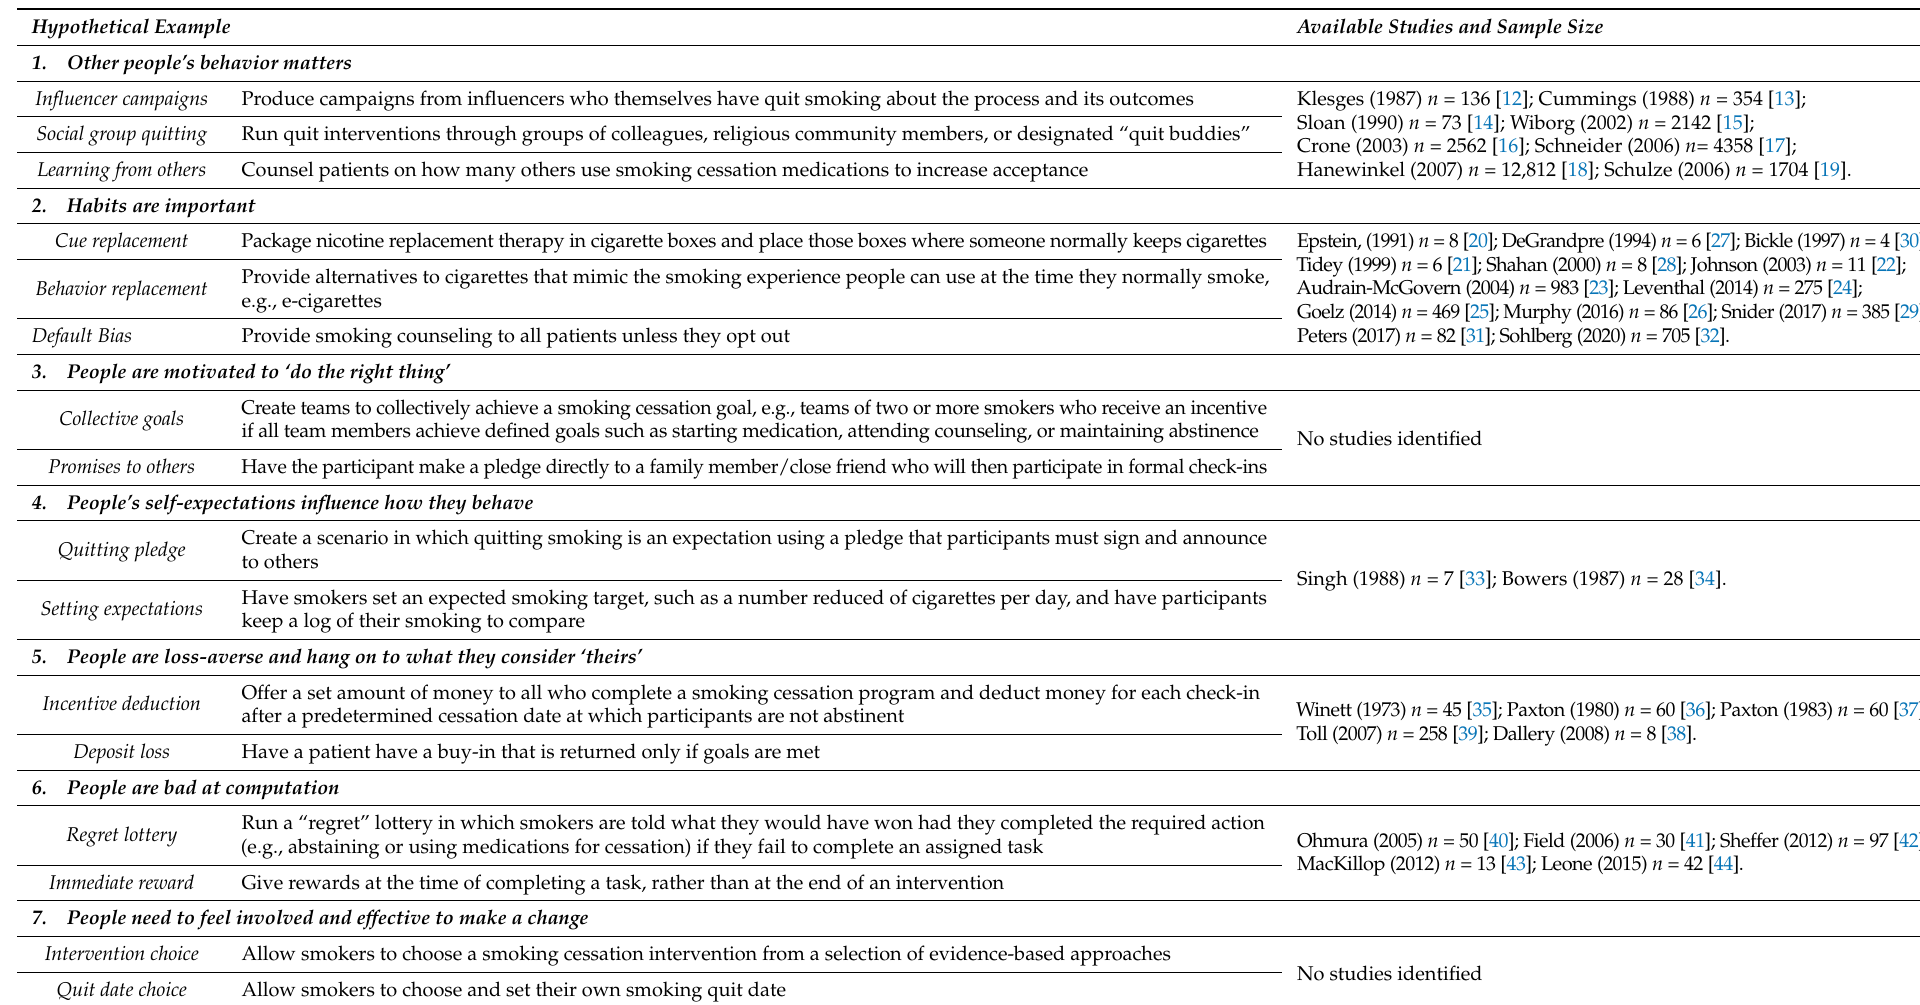
Table 1. Available studies and hypothetical examples of tobacco interventions by behavioral economic